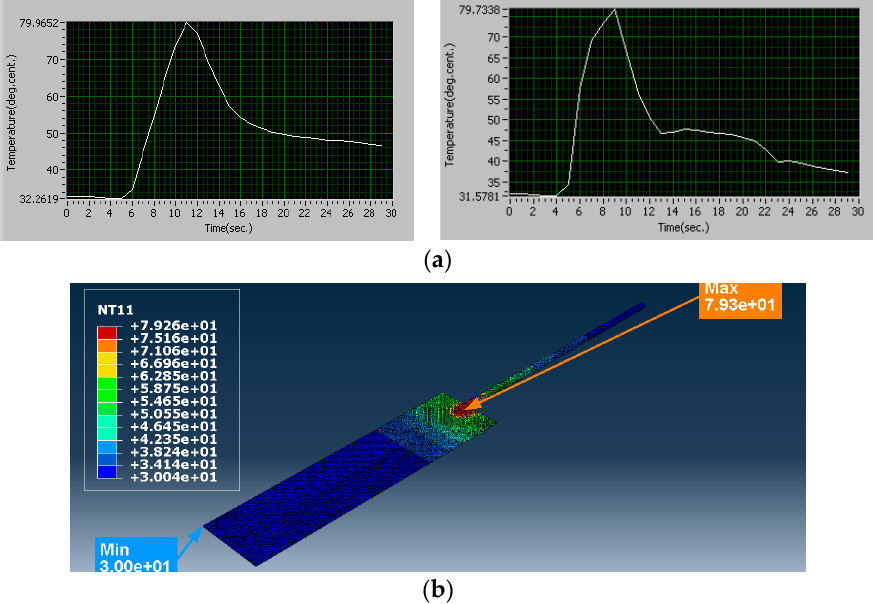
Figure 10. Trial 1, comparison of temperatures (°C): ( a ) results from experiments (Trial 1); and ( b ) result from simulation (Trial 1): Minimum temperature 30.04 °C, Maximum temperature 79.26 °C.